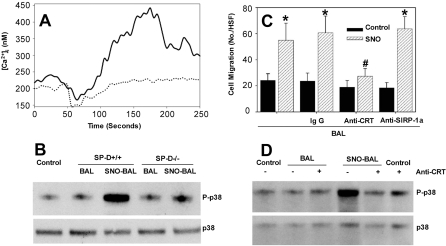
SNO-BAL Induces Inflammatory Signaling in RAW Cells via CRT(A) RAW 264.7 macrophages grown on coverslips were preloaded with fura-2AM and stimulated with BAL (100 μg/ml) or SNO-BAL (100 μg/ml) from SP-D+/+ mice. Change in [Ca2+]i was record from 50–70 cells.(B) RAW 264.7 macrophages were treated with BAL or SNO-BAL from either SP-D
+/+ or SP-D
–/– mice for 5 min. Cell lysates were analyzed for total p38 MAPK and its phosphorylated form (P-p38) by SDS-PAGE and Western blotted with phospho-specific primary antibody.(C) RAW 264.7 cells were pretreated with 2 μg/ml of anti-SIRP-1α, anti-CRT or an isotype control for 20 min prior to addition to the Boyden chamber. Treated cells were analyzed for chemotaxis to BAL (control) or SNO-BAL (SNO).(D) RAW 264.7 cell were pretreated with anti-CRT for 20 min prior to stimulation with BAL or SNO-BAL for an additional 20 min. Cell lysates were then prepared and analyzed for p38 phosphorylation via SDS PAGE and Western blot with phospho-specific primary antibody. (asterisk represents significantly different from control; pound symbol represents significantly different from control, IgG, or anti-SIRP-1α (p < 0.05)